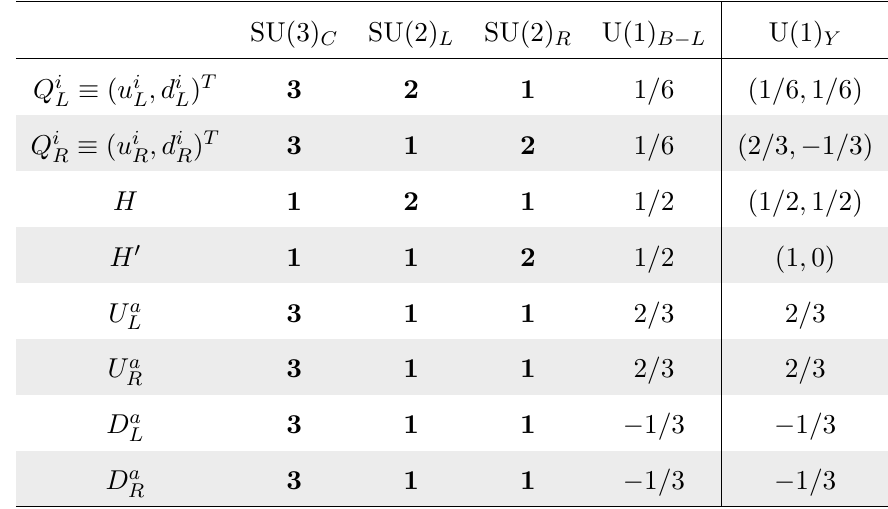
Table 1. The matter contents and their gauge charges in the minimal LR symmetric model, where U(1) Y = T R 3 + U(1) B − L . The indices i and a represent the flavors for the doublet and singlet quarks,